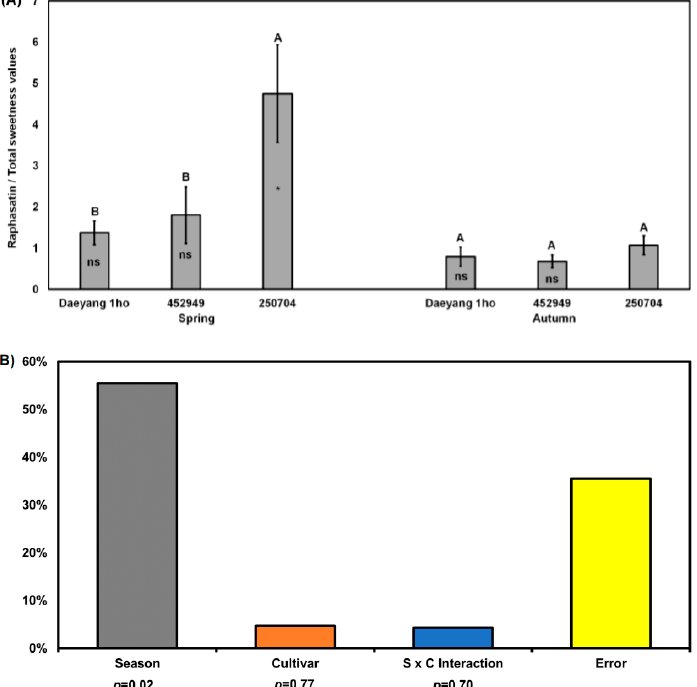
Figure 7. ( A ) Ratio of raphasatin concentration to total sugar concentration in the roots of three different radish cultivars grown in spring and autumn 2020. Total sweetness values from sugars was calculated as follows: (fructose content × 2.0) + (glucose content × 0.6) + (sucrose content × 1.0) based on sweetness value of each sugar [60]. Different capital letters above the error bars indicate significant differences among cultivars within the same season according to Tukey’s HSD test ( p < 0.05). Ns and asterisk (*) insides the bars indicate non-significantly difference and significant differences between spring and autumn roots within the same cultivar according to an unpaired t -test ( p < 0.05); ( B ) Two-way ANOVA for raphasatin concentration in radish roots from three different cultivars across two seasons. S × C indicates season and cultivar interaction. % indicated % of explained variation.